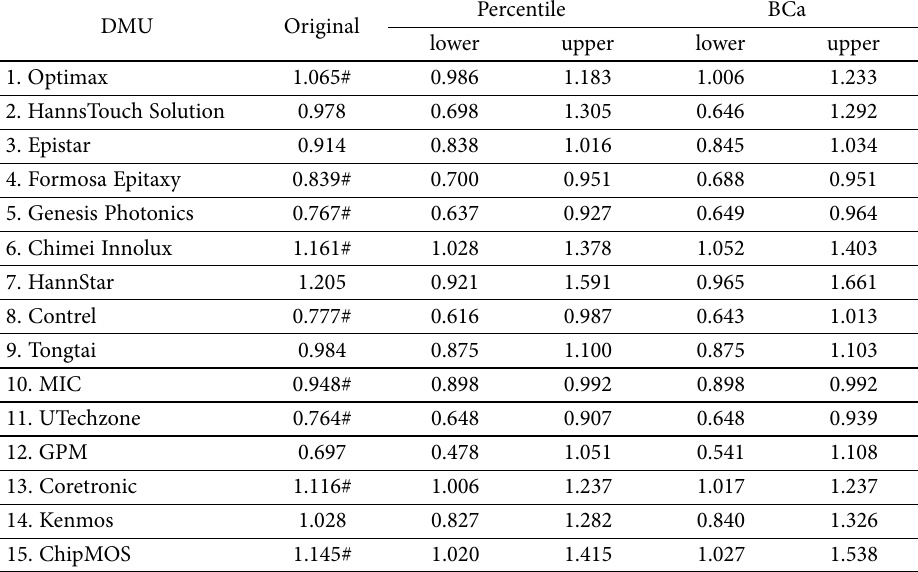
Table 11. Total factor productivity with bootstrap Percentile BCa DMU Original lower upper lower